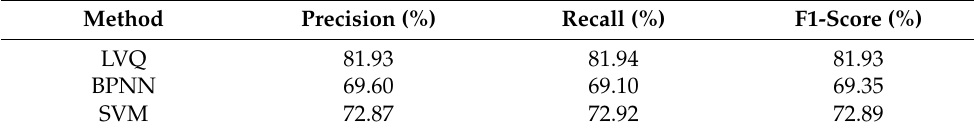
Table 13. Performance evaluation results of classification models.